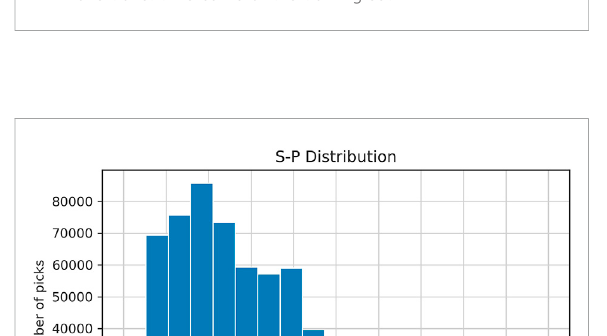
FIGURE 3 P-wave travel time curve of the training set.